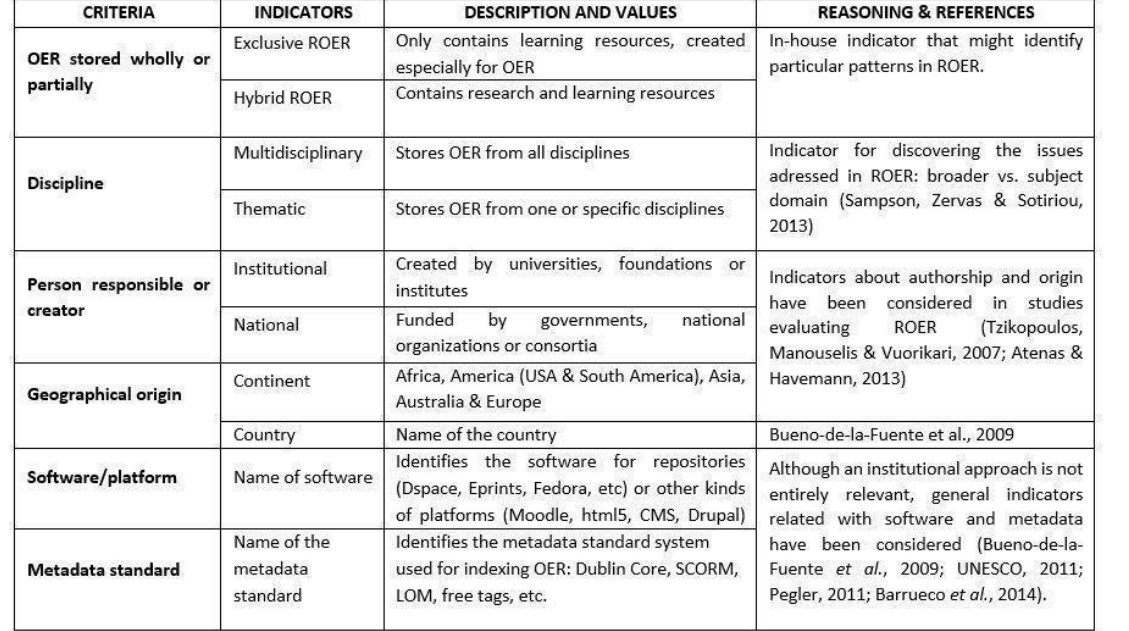
Category 1: General indicators: Types and